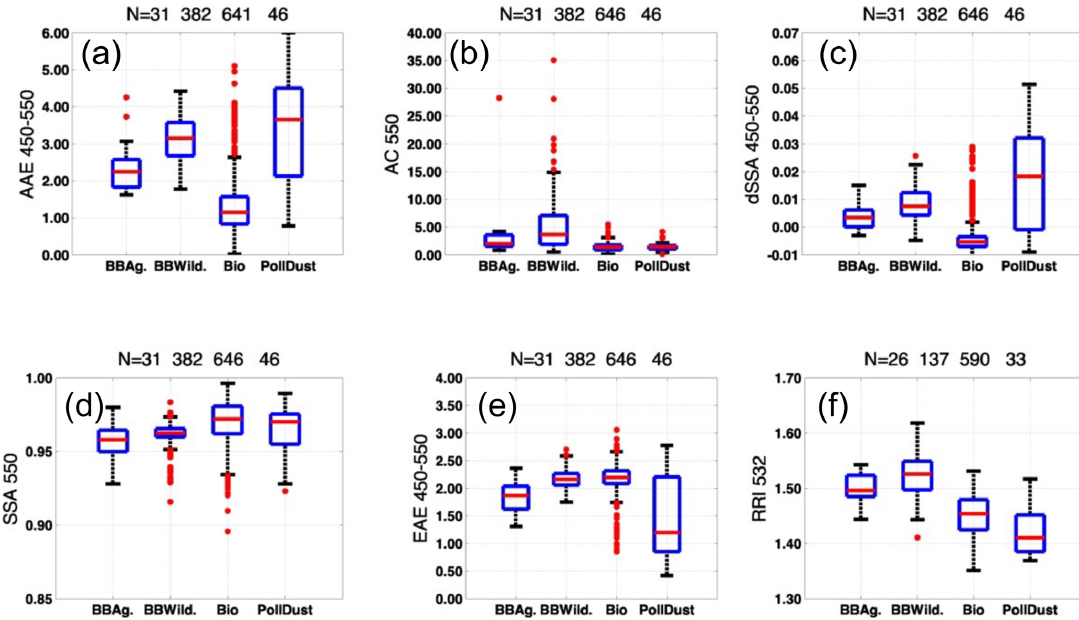
Figure 5. Optical characterization of PS-AMTs using the LARGE, PI-Neph and DASH-SP instruments (see Table 1). In each blue box, the red horizontal line indicates the median, and the bottom and top edges of the box indicate the 25th and 75th percentiles, respectively. The black whiskers extend to the most extreme data points not considered outliers, and the outliers are plotted individually using red points. (a) AAE: absorption Ångström exponent; (b) AC: absorption coefficient; (c) dSSA: difference in single scattering albedo; (d) SSA: single scattering albedo; (e) EAE: extinction Ångström exponent; (f) RRI: real refractive index. Numbers in the title correspond to the number of points behind each box–whisker plot for the respective BBAg., BBWild., Bio. and PollDust PS-AMTs.